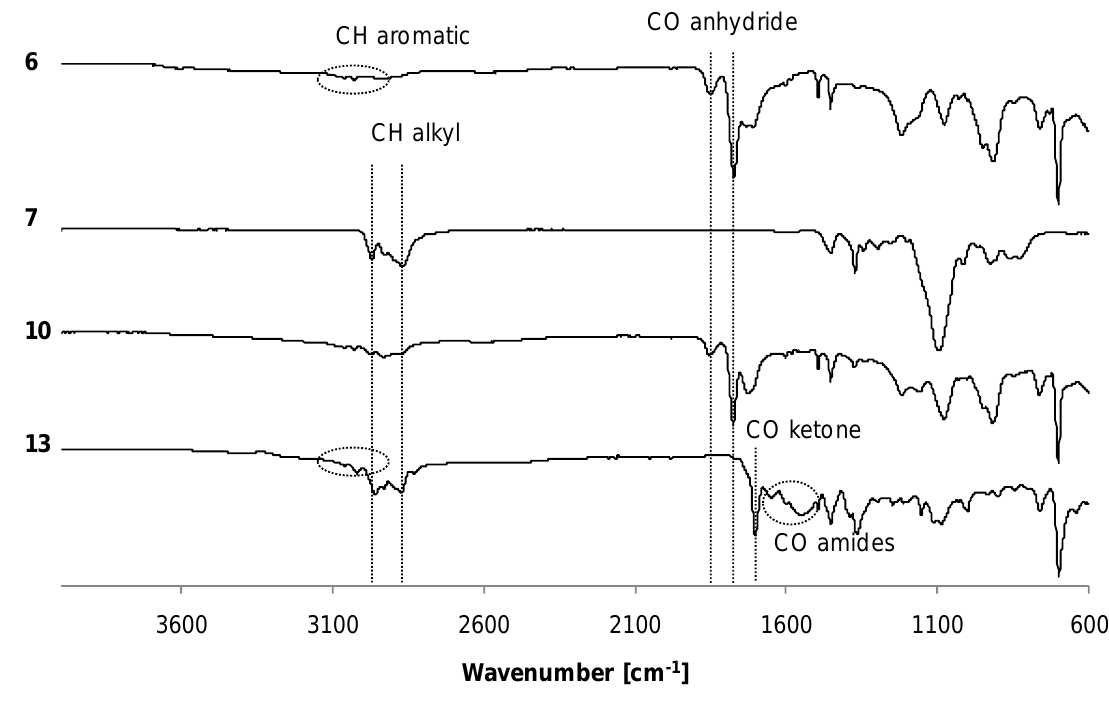
Figure 5. Fourier transform infrared spectroscopy (FTIR) spectra of copolymers 6 , 7 , 10 and 13